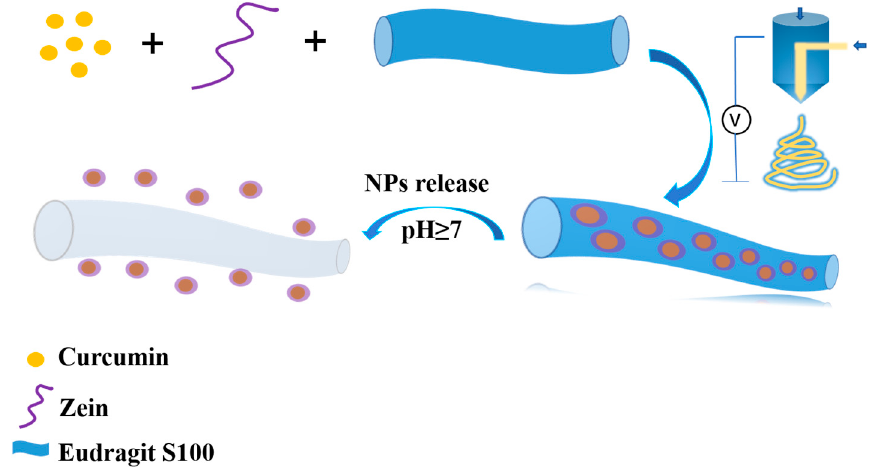
Figure 1. The schematic diagram of Z–Cur NPs assembly and encapsulation in fibermats by co-axial electrospinning and release of Cur.